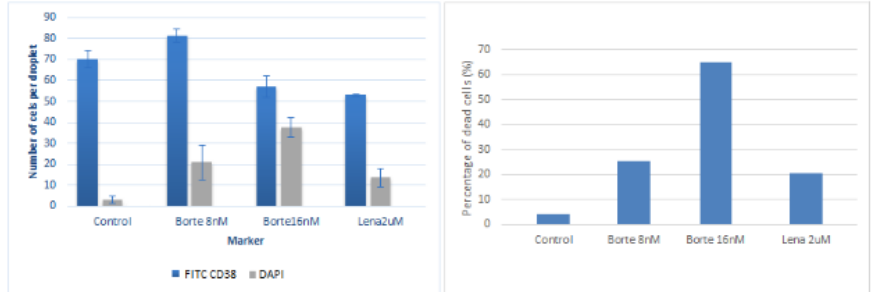
Figure 7. Left : Number of FITC CD38 and DAPI cells per bead for the studied cases (control, bortezomib 16 nM, 8 nM and lenalidomide 2 uM). Right : Percentage of dead cells for control beads, bortezomib 1 nM and 8 nM and lenalidomide 2 uM.